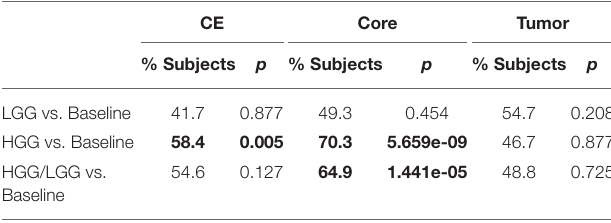
TABLE 1 | Ratio in % of better performing subjects compared to